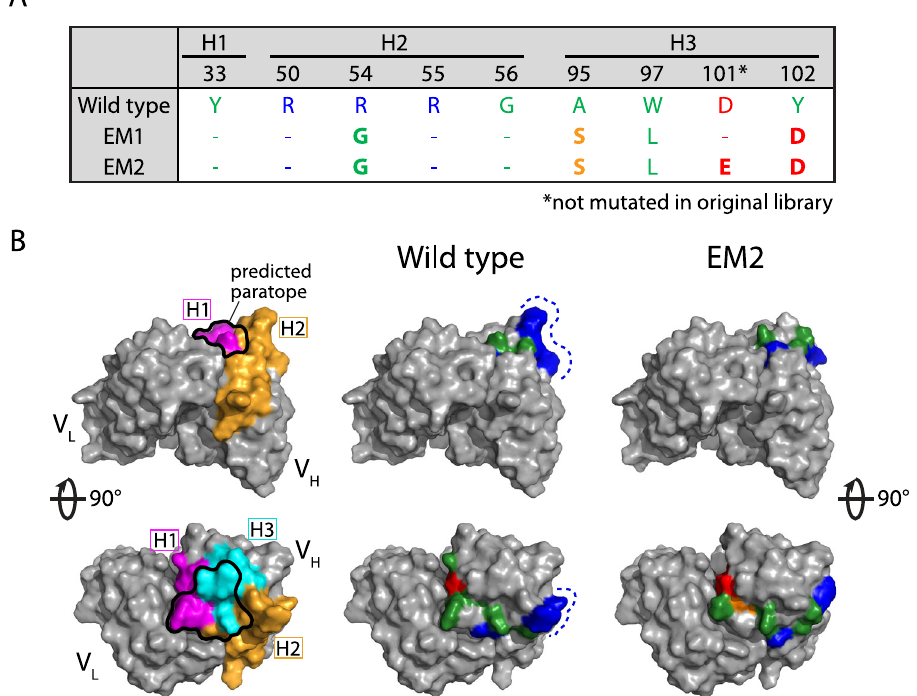
Fig. 7 Structural modeling analysis of emibetuzumab mutants with co-optimized af fi nity and speci fi city. A Summary of the mutated CDR sites in the three heavy chain CDRs (H1, H2, and H3) for wild-type emibetuzumab and two mutants (EM1 and EM2). B Structural models of wild-type emibetuzumab and EM2 Fv regions. The predicted paratope is located primarily in the H1 and H3 CDRs and overlaps with the mutated sites. The structural models reveal a protruding positively charged patch (blue) in the wild-type antibody, which is located outside the predicted paratope, that is eliminated in the EM2 mutant. Some alterations to the paratope region and adjacent regions are also apparent in the EM2 mutant. The amino acids at the mutated sites in the structural models are colored as blue (Arg), red (Asp and Glu), green (Gly, Ala, Leu, Tyr, Trp) and orange